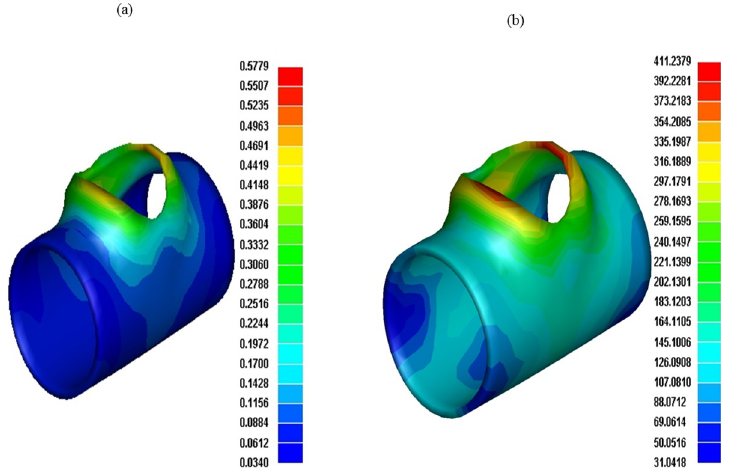
Fig 16. Effective strain (a) and effective stress (b) in Case 1.